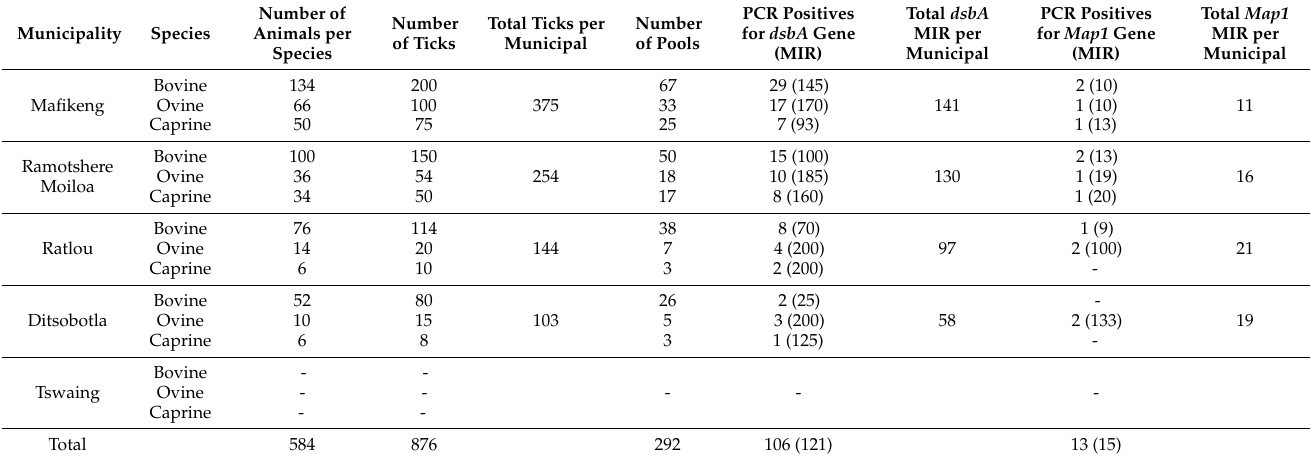
Table 2. Number of samples collected throughout the 5 municipalities of the Ngaka Modiri Molema District and DNA pool samples screened by PCR dsbA and Map1